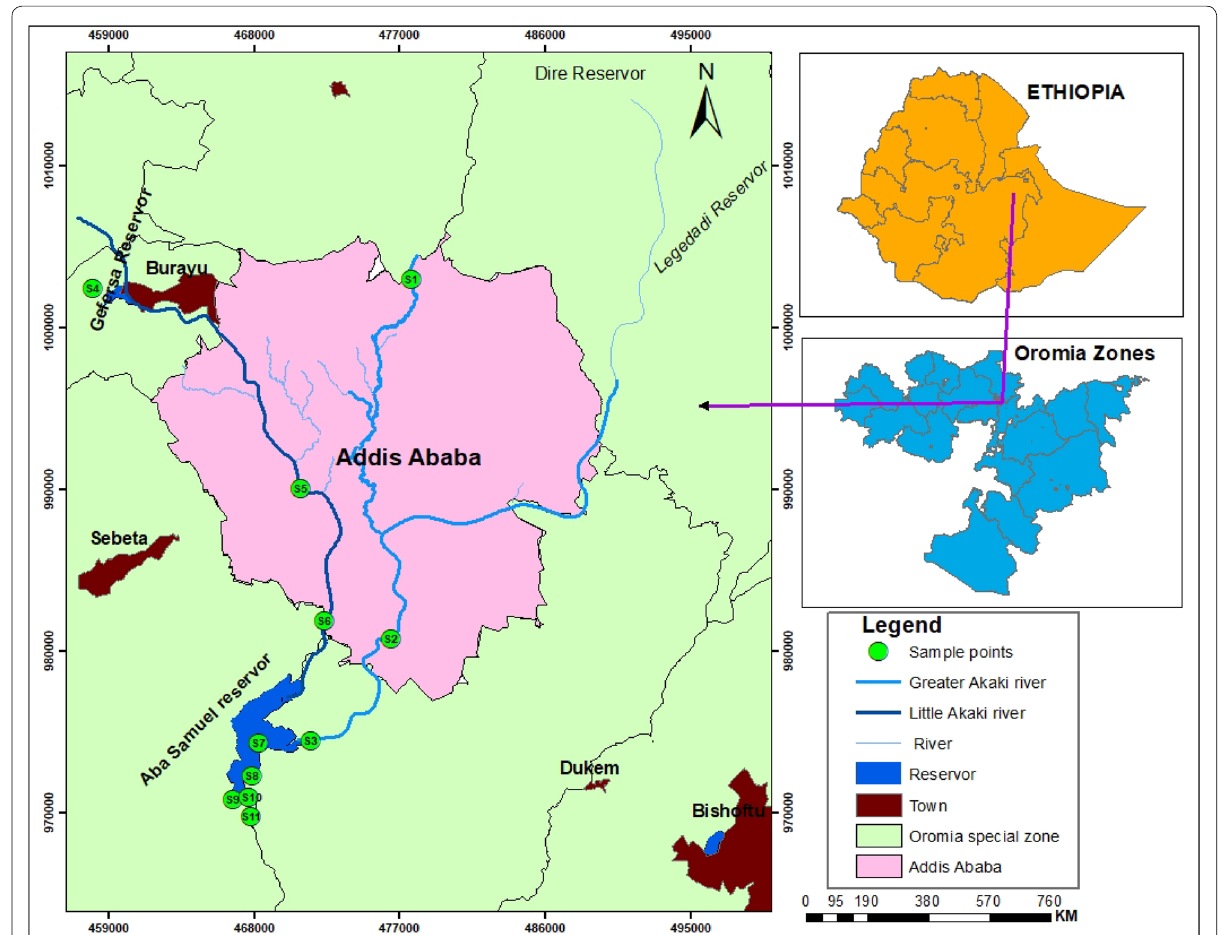
Fig. 1 Map of the study area showing the sampling